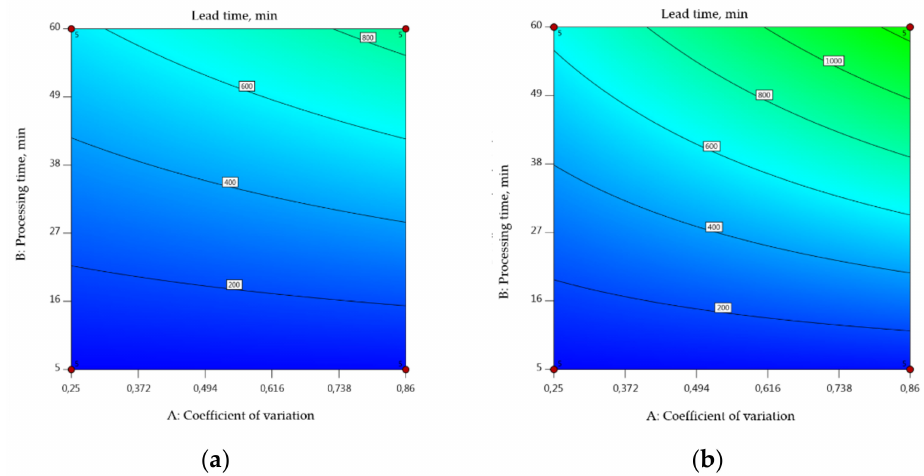
Figure 4. Response surface contour plots: ( a ) Effects of coefficient of variation and operation time on lead time for the process without bottleneck and two Kanban cards in each operation; ( b ) Effects of coefficient of variation and operation time on lead time for the process without a bottleneck and five Kanban cards in each operation.